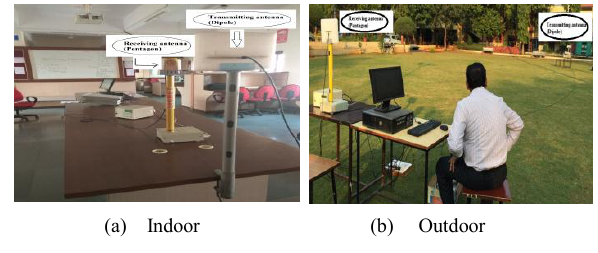
Figure 4. Experimental set up